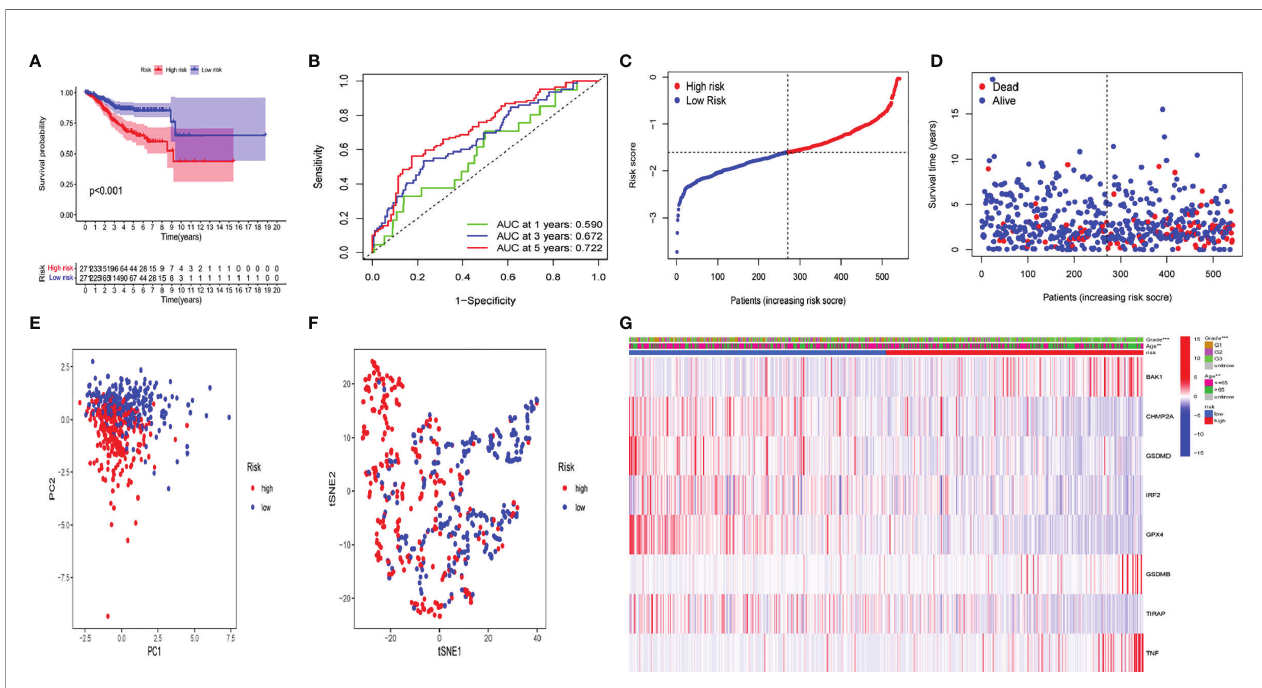
FIGURE 10 | The prognostic value of the risk model in The Cancer Genome Atlas (TCGA) data set. (A) Kaplan – Meier survival curves of overall survival (OS) of patients in the high- and low-risk groups. (B) One-year, 3-year, and 5-year receiver operating characteristic (ROC) curves for OS prediction based on pyroptosis- related gene. (C) Risk grade distribution of risk model. (D) Different survival statuses and survival times between low- and high-risk groups. (E) Principal component analysis (PCA) of the overall RNA expression data between low-risk and high-risk groups. (F) T-distributed stochastic neighbor embedding (t-SNE) analysis of the overall RNA expression data between low- and high-risk groups. (G) Clinical evaluation by pyroptosis-related